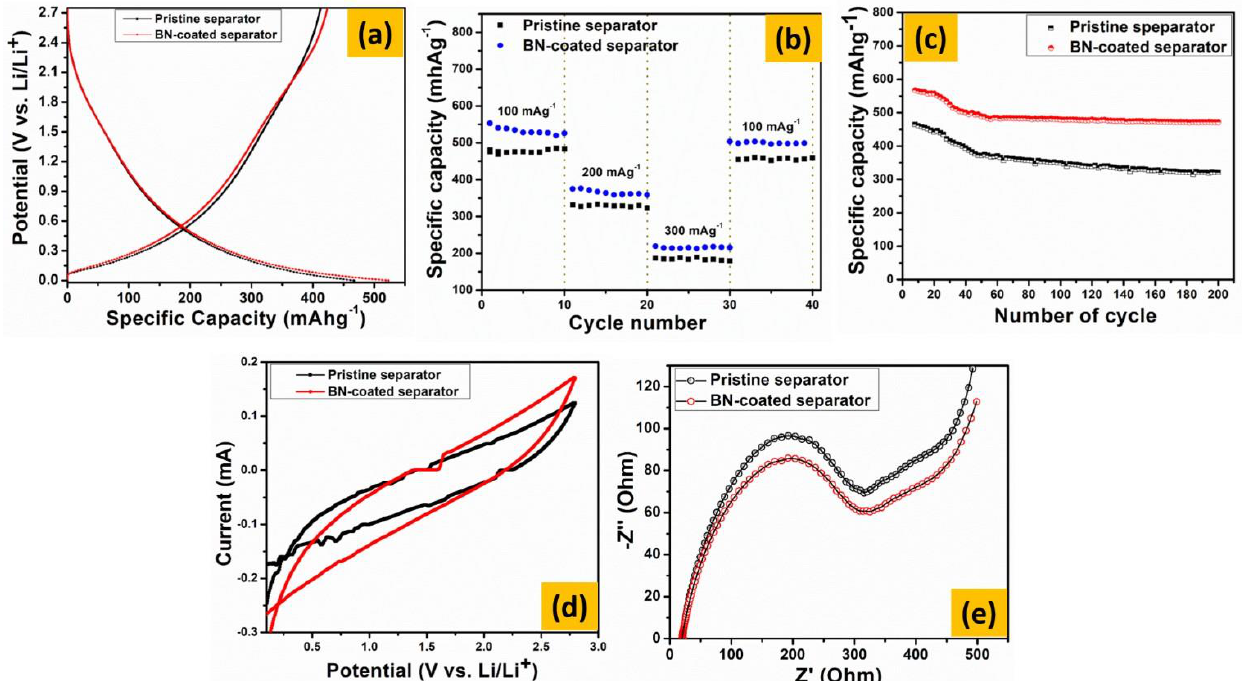
Figure 6. Electrochemical characteristics of fabricated cell with MWCNTs anode using pristine separator and BN-coated separator. ( a ) Charge-discharge voltage profiles measured at 65 ◦ C for the first cycle at a current density of 100 mAg − 1 , ( b ) rate capability performance at various current densities, ( c ) cyclic performance at a current density of 100 mAg − 1 and temperature of 65 ◦ C, ( d ) cyclic voltammograms at a scan rate of 0.5 mV s − 1 , ( e ) and EIS Nyquist plots of electrodes with pristine separator (black) and BN-coated separator